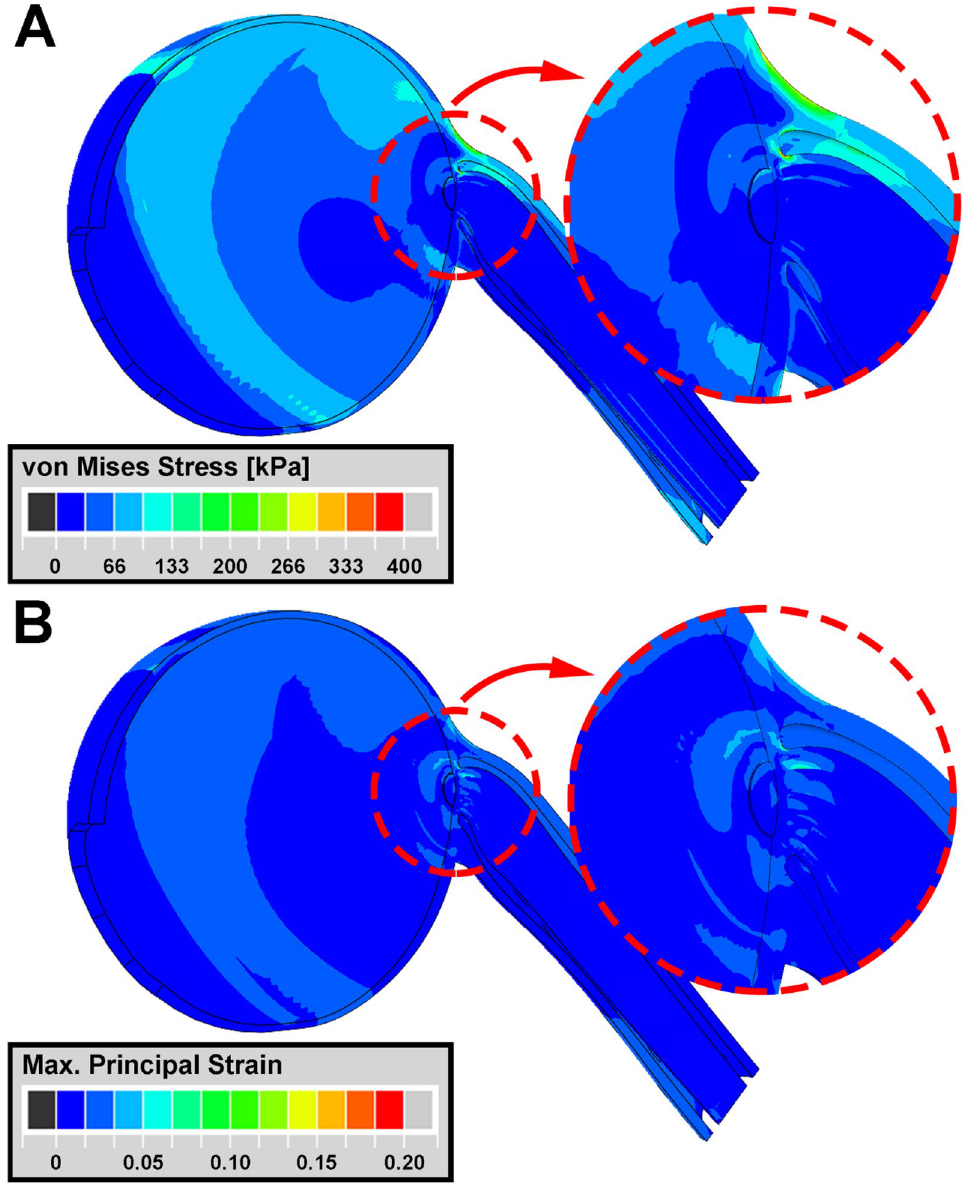
Figure 1. Simulation of adduction to 32° from initial ON tethering at 26°, employing average measured tissue hyperelastic functions. Heat maps of ( A ) von Mises stress and ( B ) principal strain. Stress–strain effects mainly occur in and around the ON head in the region enclosed by red dotted